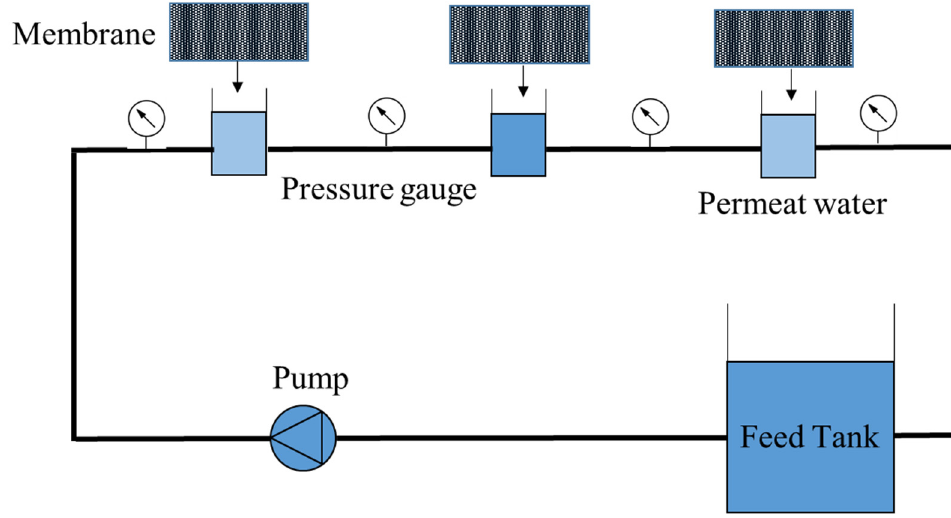
Figure 1. The reverse osmosis model. The amount of water passing through the membrane enters the container for mea- suring water volume through the tube at the end of it, and the water permeability is determined by Equation (1)